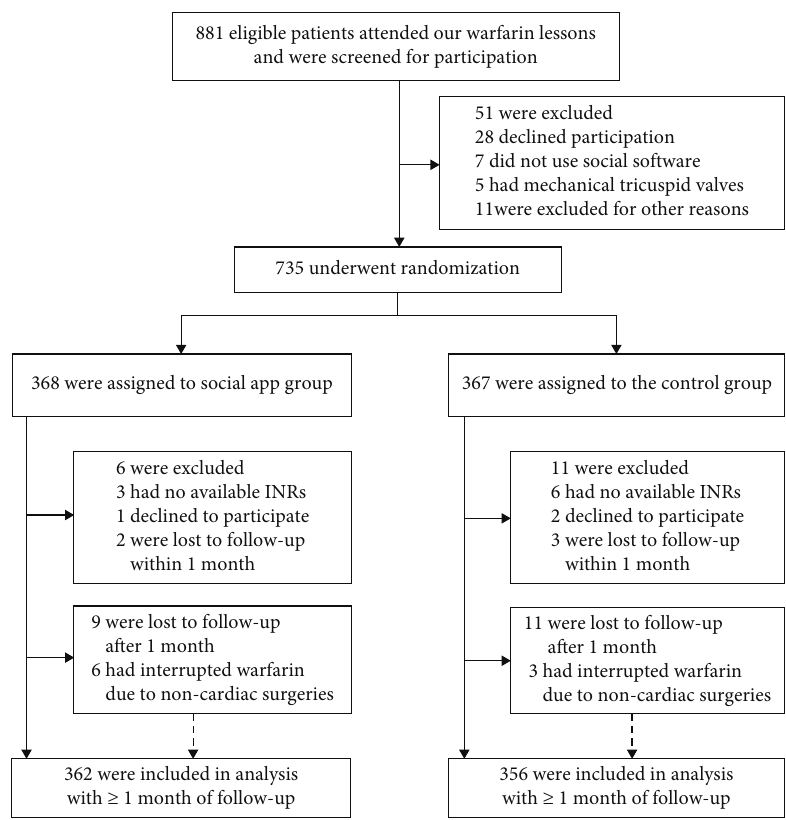
Figure 2: Enrolment and fl owchart of the